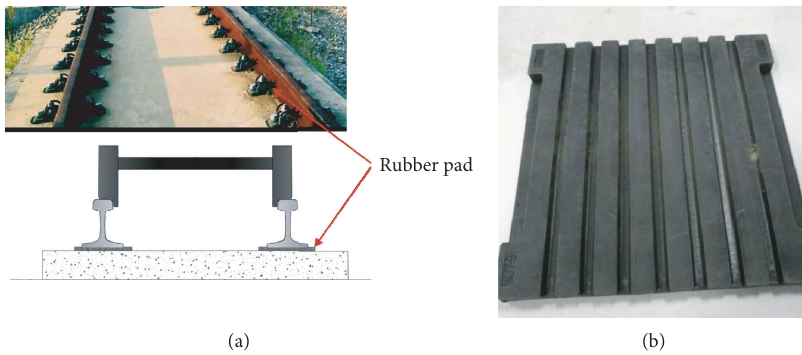
Figure 5: WJ-7B fastener system: (a) rail fastener system; (b) underrail rubber